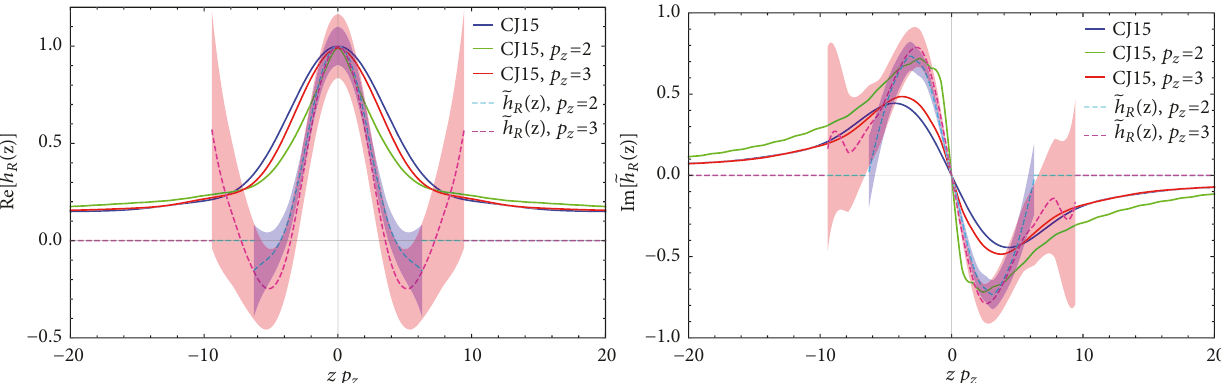
Figure 19: Real (left) and imaginary (right) part of LP 3 ’s renormalized unpolarized matrix elements (dashed lines) and phenomenological PDFs compared in coordinate space as a function of 𝑧𝑃 3 . Data are presented for the scale of 5.76 GeV 2 in the MS scheme. The solid lines are the Fourier transforms of the corresponding CJ15 PDF (blue), after matching and mass corrections (green and red). Source: [181],